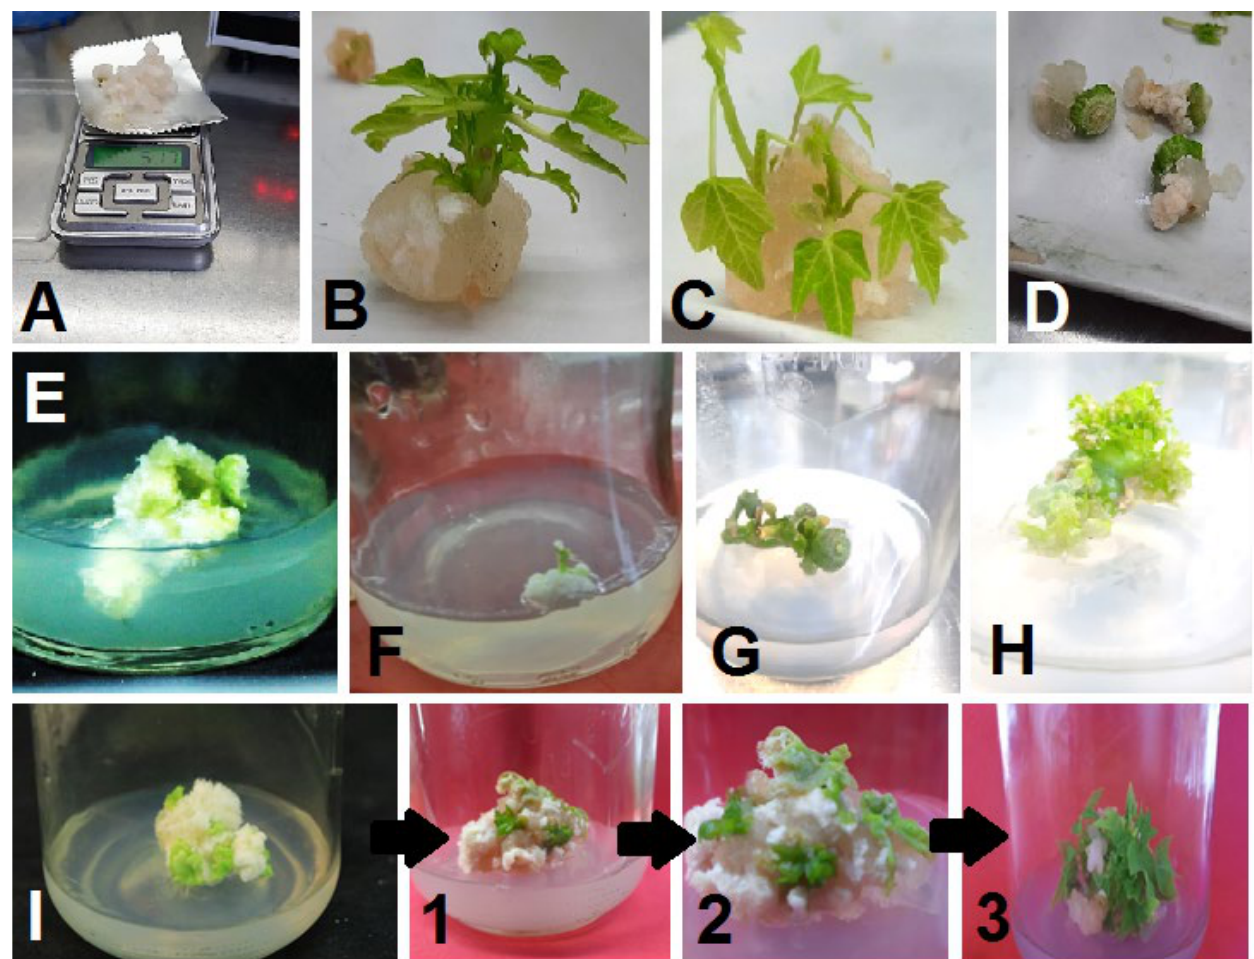
Figure 1. Micro-propagation of hybrid papaya cv. 'Red Lady' using various explant types. Callus induction (A), from shoot tip (B), Stem nodules (C), Internodes (D), Young leaf (E); and Floral buds. The floral bud explants were developed to parthenocarpy fruits (G) and direct shoots organogenesis was observed on young fruit (H). On the other hand, indirect organogenesis stages on callus were observed in (I, 1, 2,